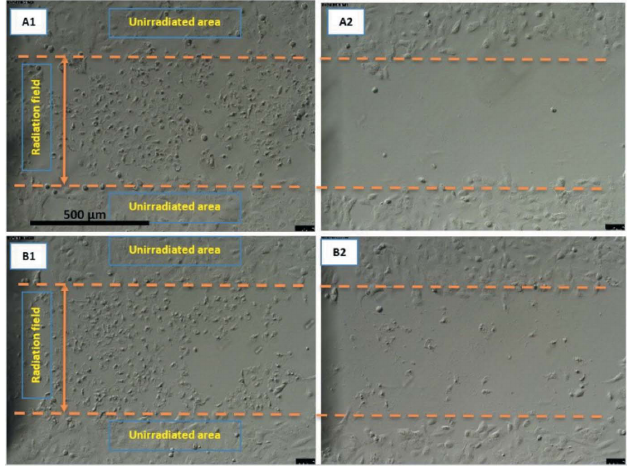
Figure 11 Human prostate DU145 cancer cells irradiated with 1000 Gy SBB. The radiation field is marked by orange dotted lines. (A1) Control (no AuNPs) 24 h, (A2) control (no AuNPs) 48 h, (B1) treated group (with 1 m M AuNPs) 24 h and (B2) treated group (with 1 m M AuNPs) 48 h post-irradiation with PBS